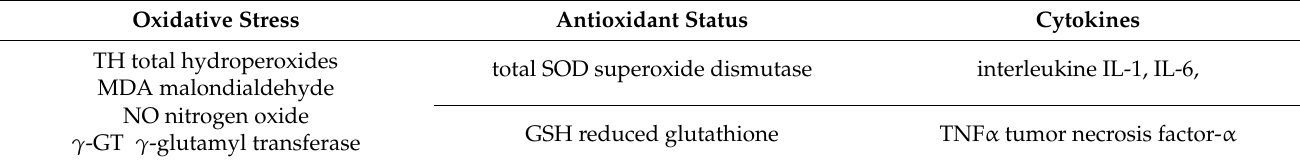
Table 3. Ozone-specific stress markers during systemic ozone treatment, recommended to follow the treatment